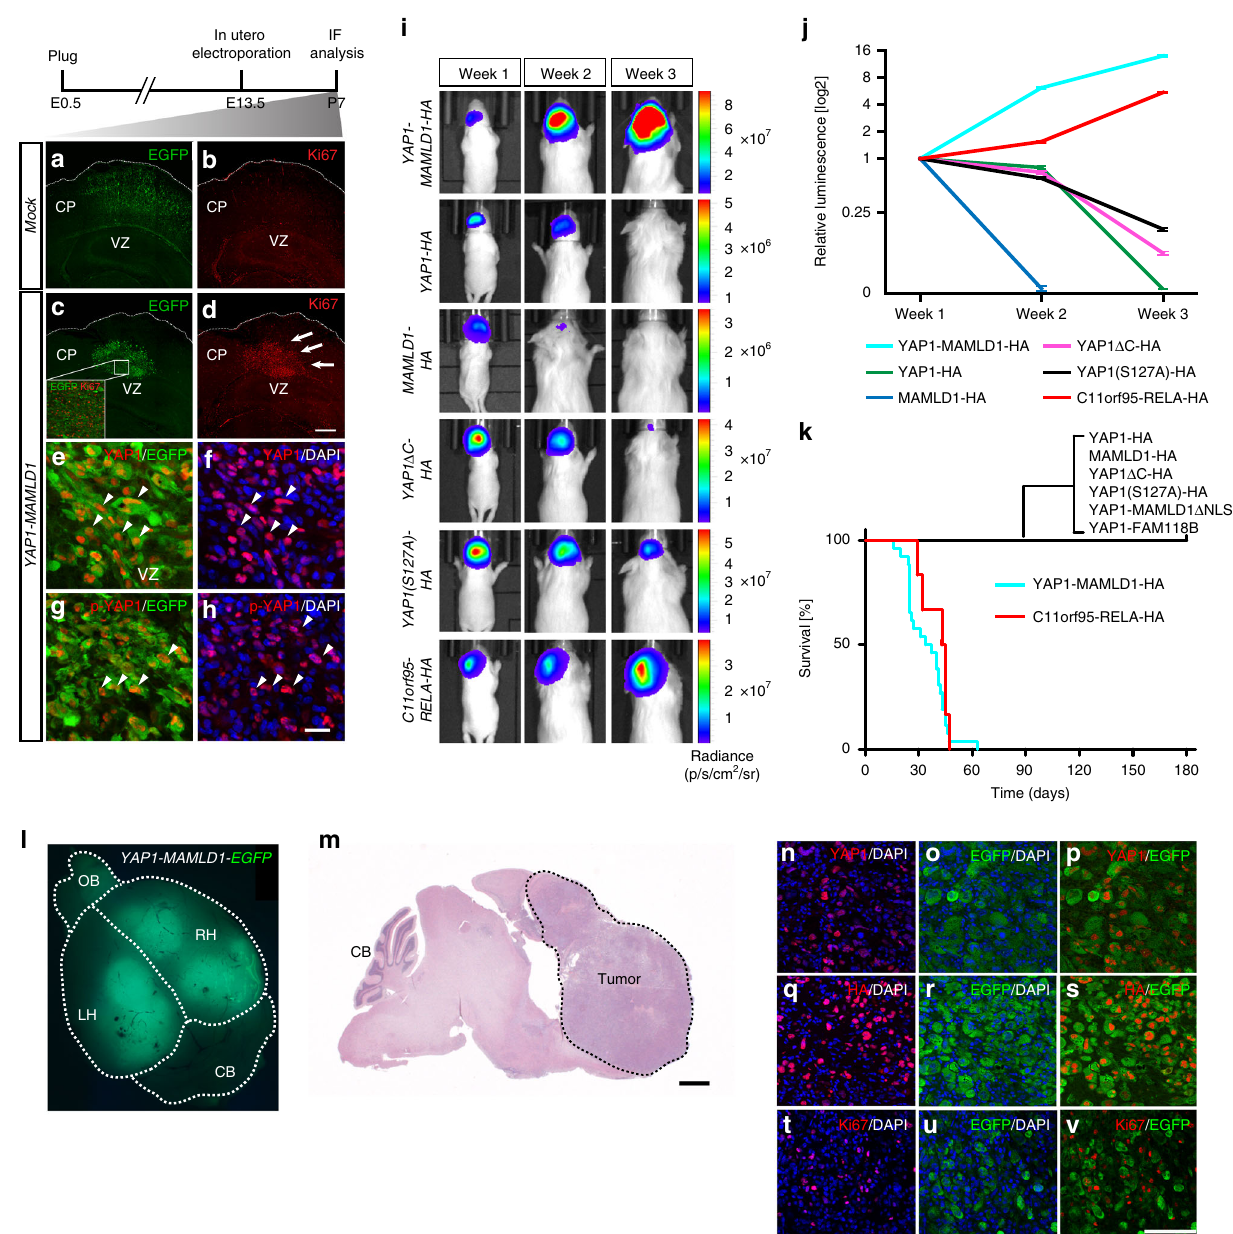
Fig. 3 YAP1-MAMLD1 fusion drives tumor formation in vivo. a – h Immuno fl uorescence micrographs of supratentorial brain regions stained for EGFP a , c or Ki67 b , d from 7-day-old mice subjected to electroporation with YAP1-MAMLD1 or mock (EGFP alone) constructs. Insets in c represents electroporated cells positive for Ki67. Representative images of double staining for e YAP1/EGFP or f YAP1/DAPI and g p-YAP1/EGFP or h p-YAP1/DAPI in cells expressing the YAP1-MAMLD1 fusion gene. Arrows in d indicate abnormally proliferating cells. Arrowheads in e , f and in g , h indicate the same area, respectively (scale bar in d , 400 µ m for a – d and 100 µ m for inset; the bars in h , 25 µ m for e – h ). CP cortical plate, VZ ventricular zone. i , j Luciferase-based ( i ) in vivo bioluminescence images and j relative changes of luminescence at weeks 1 – 3 after birth of animals electroporated with indicated constructs. Error bars in ( j ) indicate mean ±S.D. k Kaplan – Meier curves for animals electroporated with the YAP1-MAMLD1-HA (cyan, n = 26, median survival = 35.5 days), C11orf95- RELA-HA (red, n = 6, median survival = 45 days) or indicated controls ( n = 6 for YAP1-HA, n = 5 for MAMLD1-HA, n = 6 for YAP1 Δ C-HA, n = 8 for YAP1 (S127A)-HA, n = 6 for YAP1-MAMLD Δ NLS-HA, n = 8 for YAP1-FAM118B-HA). l Immuno fl uorescence micrograph of a resected 21-day-old mouse brain electroporated with YAP1-MAMLD1 IRES-EGFP with the T2TP transposase. EGFP-positive cells have broadly spread into both the left (LH) and right (RH) hemispheres (OB olfactory bulb, CB cerebellum). m H&E staining of YAP1-MAMLD1-driven tumor indicated by a dotted line. CB cerebellum. Scale bar, 1 mm. n – v Double staining of cells derived from YAP1-MAMLD1 -induced tumors with indicated antibodies and DAPI (scale bar, 100 µ